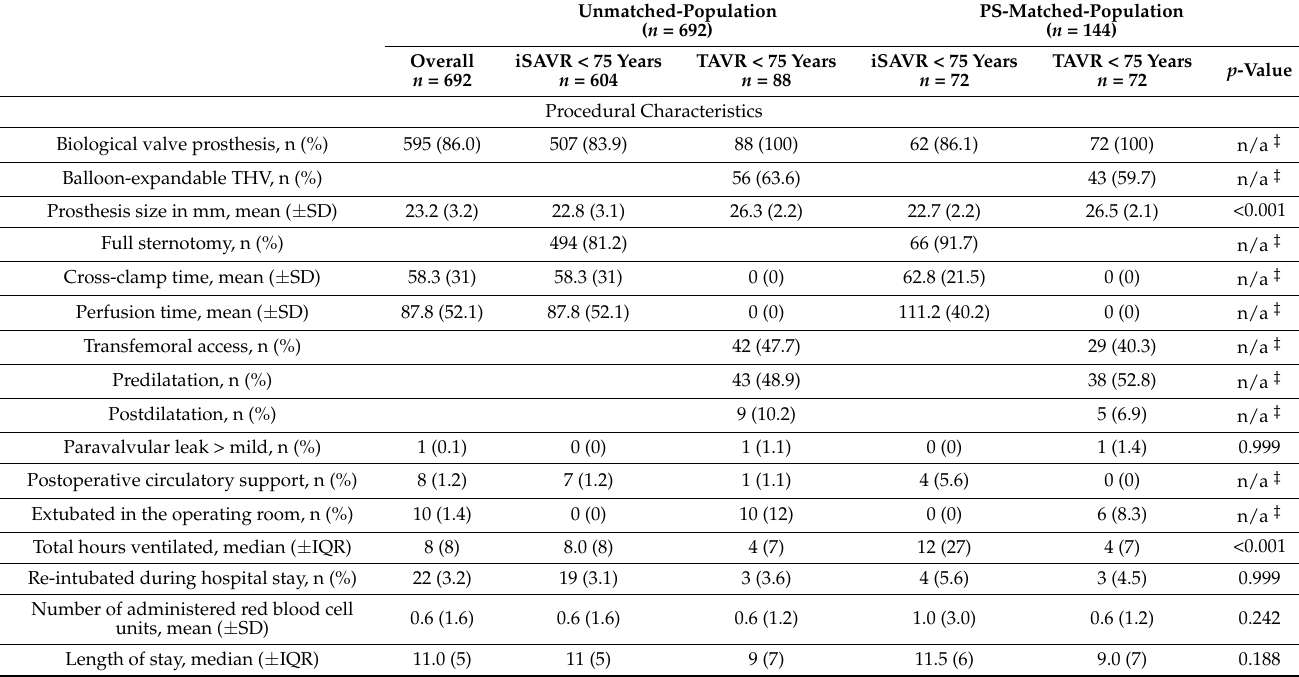
Table 3. Procedural characteristics of the unmatched and matched